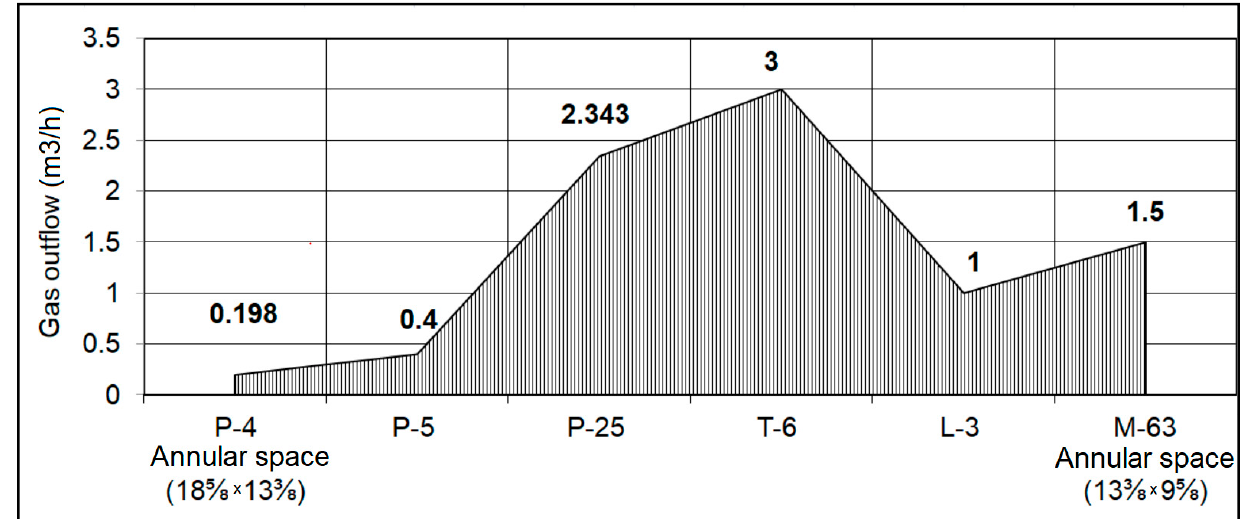
Figure 2. Gas outflows from the ring space in boreholes drilled in the Carpathian Foredeep and Carpathians in the years 2008—2011. P-4—Pogwizdów 4, P-5—Pogwizdów 5, P-25—Pruchnik 25, T-6—Terliczka 6K, L-3— Ł apanów 3, M-63—Mirocin 63.